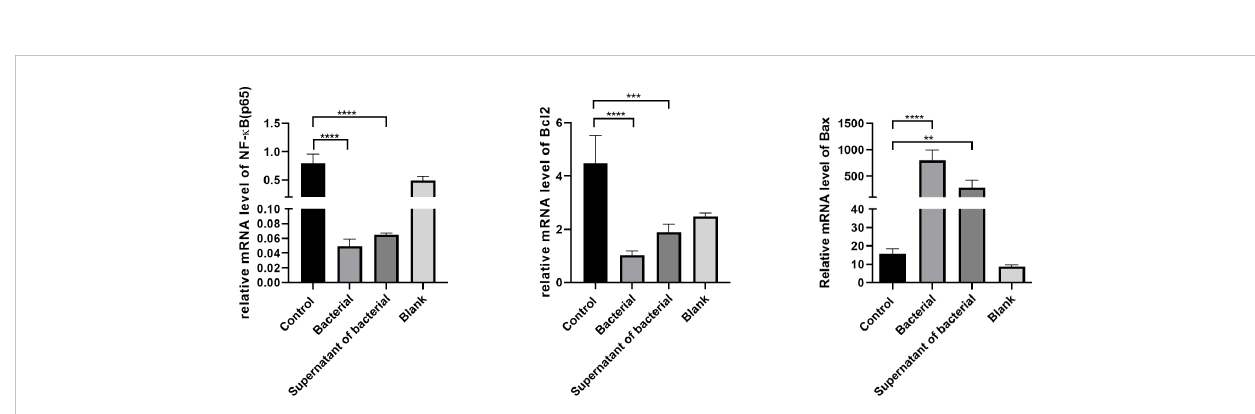
FIGURE 7 The expression of NF- k B, Bcl-2, and Bax in colon tissues by RT-qPCR. The data are described by mean ± SEM and compared by one-way ANOVA. **P<0.001, ***P<0.0005, and ****P<0.0001.